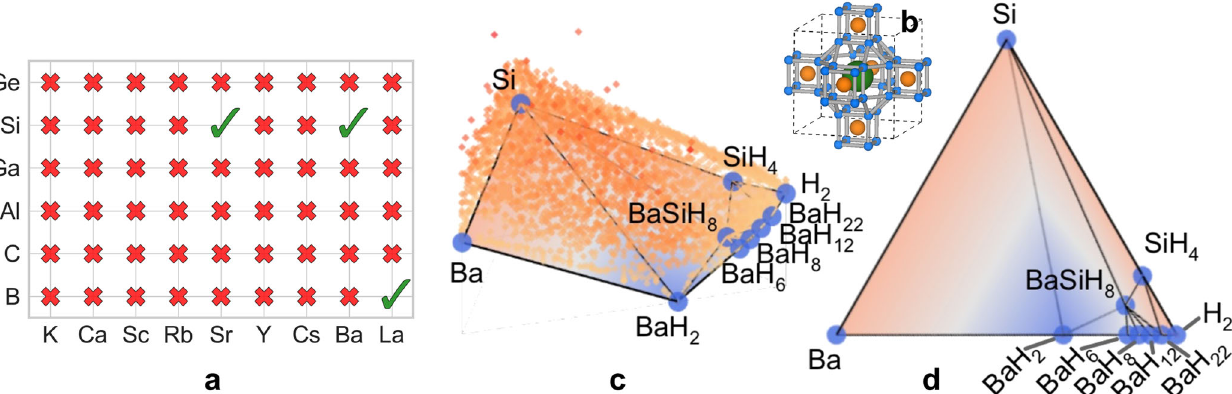
Fig. 1 Elemental composition and phase space search. a Dynamical stability of the XY H 8 structure at 50 GPa for various combinations of X and Y elements. Dynamically stable and unstable compounds are indicated by red crosses and green ticks, respectively. b Crystal structure of Fm 3 m XY H 8 in the fcc conventional unit cell; H atoms are shown in blue, H-H bonds in grey, and the lighter (heavier) atom in orange (green). c Ternary convex hull for BaSiH 8 at 100 GPa - side view; sampled structures are shown as orange dots. d Ternary convex hull for BaSiH 8 at 100 GPa - top view. In c and d the color scale (from orange to blue) represents the depth of the hull with respect to the elemental composition, from 0 to − 0.7 eV/atom; stable compositions are shown as blue dots and are